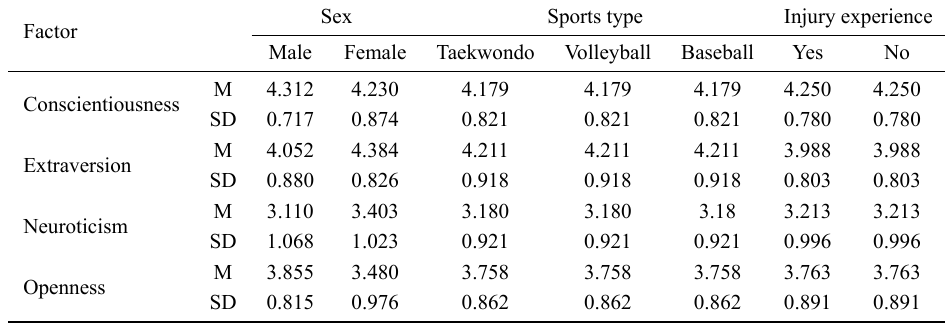
Table 3. Descriptive statistics of personality characteristics by demographic characteristics.